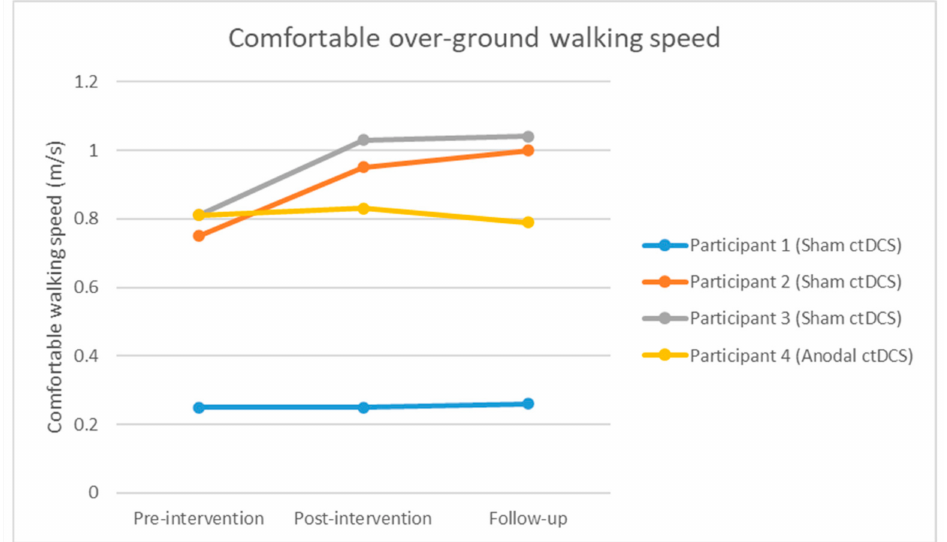
Figure 7. Comfortable walking speed at pre-intervention, post-intervention and follow-up assessment